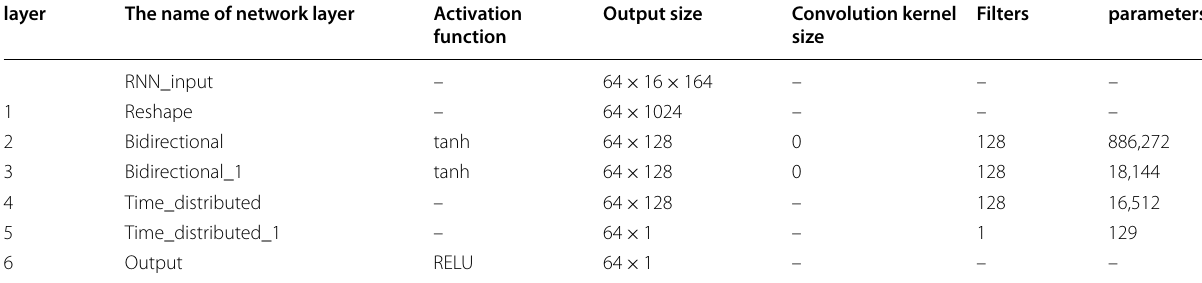
Table 3 The detailed network parameters of GRU layer The name of network